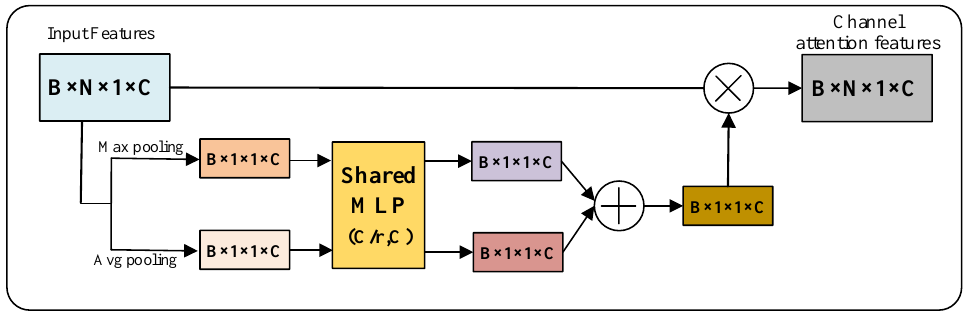
Figure 13. Point cloud channel attention mechanism A n .